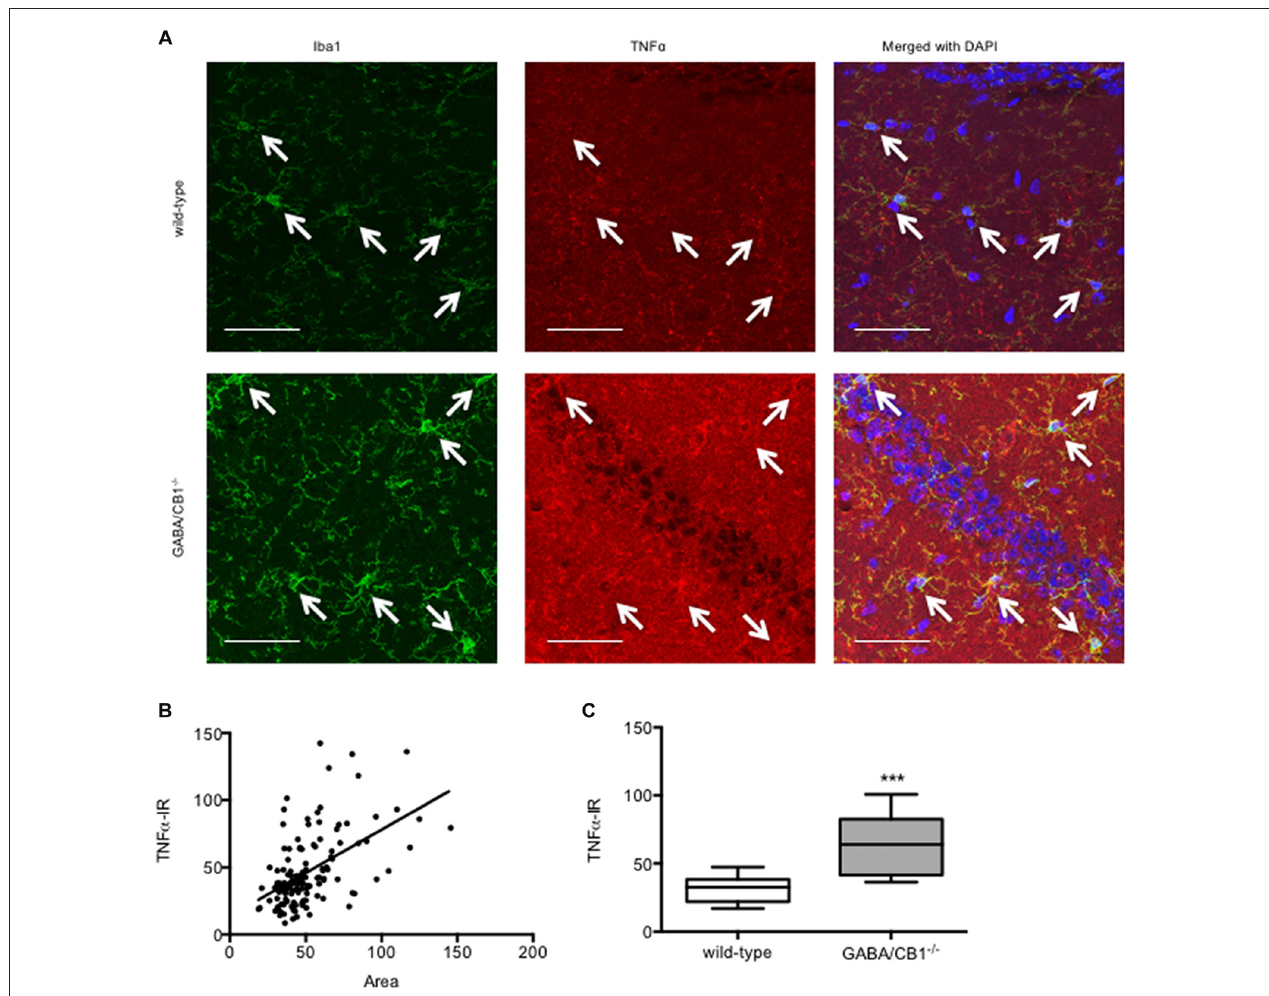
FIGURE 5 | (A) Representative microphotograph of confocal images of Iba1 (green) and TNF α (red) colocalization. Scale bar represents 50 µ m. White arrows point to Iba1+ microglia. (B) Correlation between microglial size and TNF α immunoreactivity. Microglia ( n = 132) in the hippocampus of saline-treated WT and GABA/CB1 − / − mice were analyzed. (C) TNF α immunoreactivity of microglia cells in the hippocampus of saline-treated WT and GABA/CB1 − / − mice ( n = 60–72). ∗∗∗ p < 0.001 using Mann-Whitney U